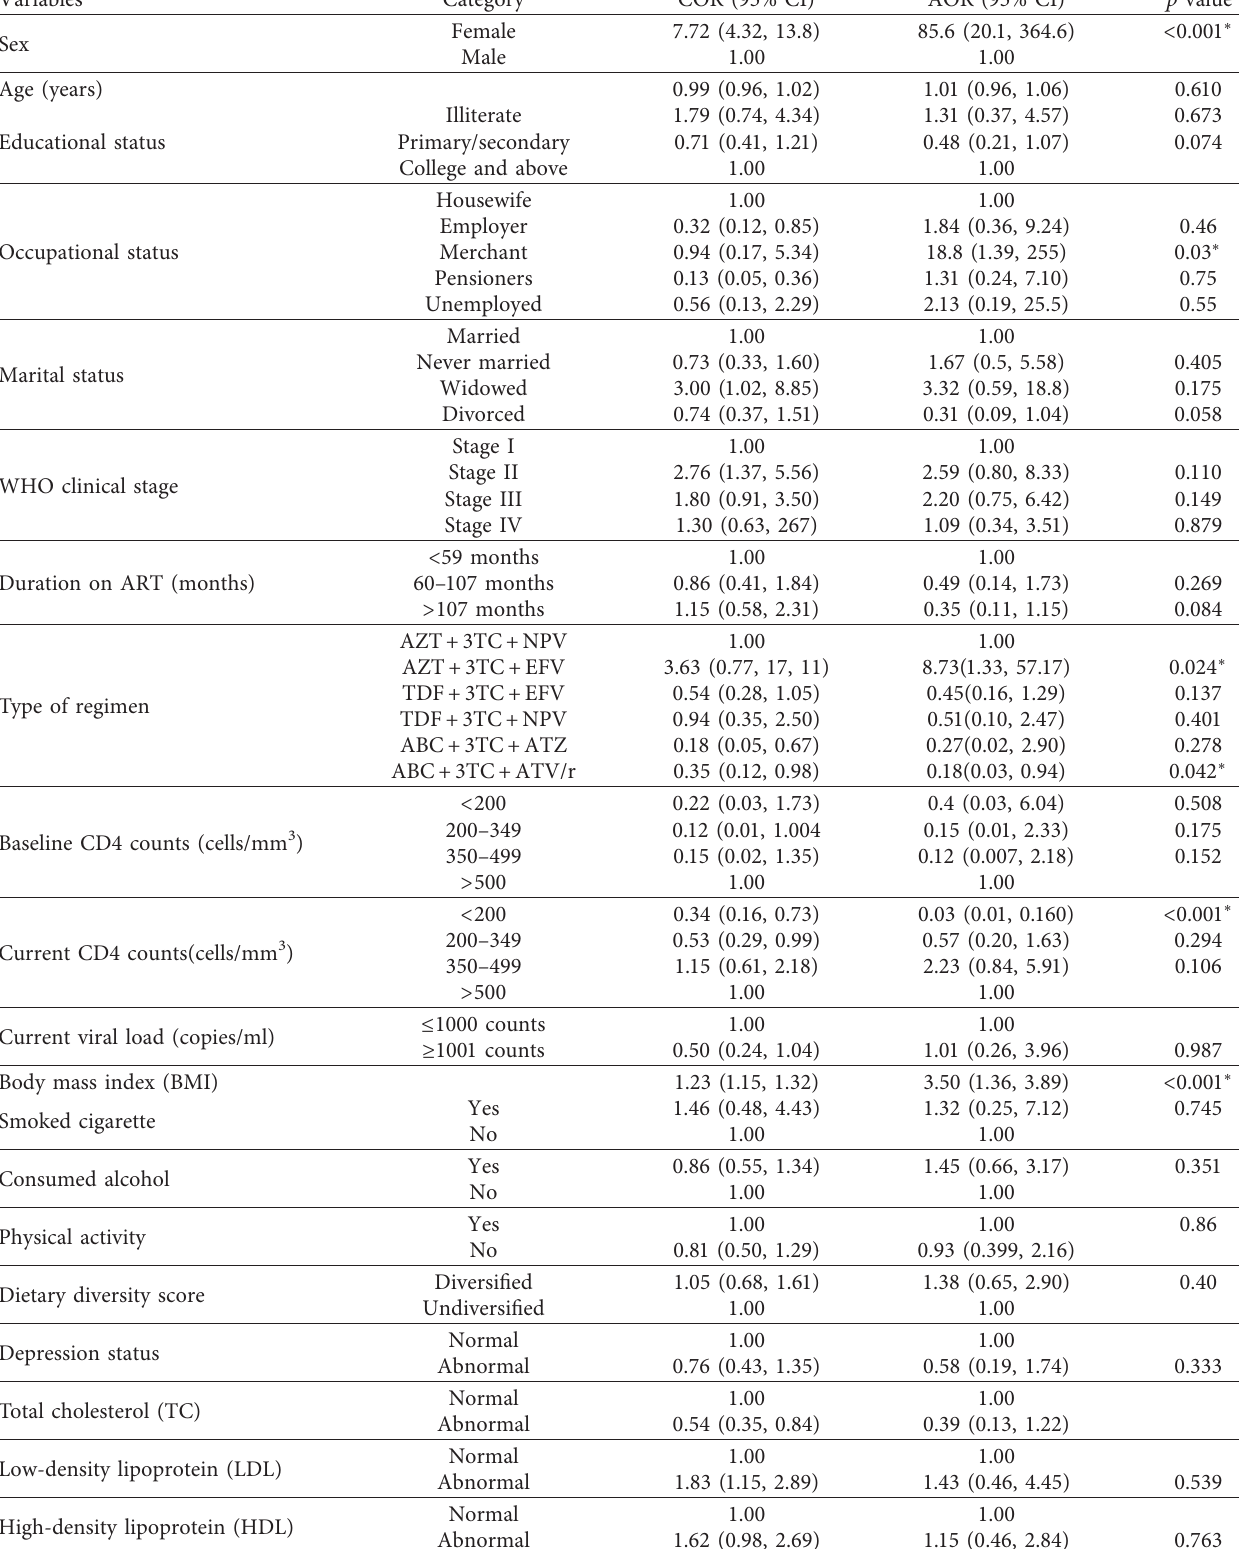
Table 6: Multivariable binary logistic regression analysis to identify factors associated with central obesity among HIV patients who received ART at armed force comprehensive and specialized hospital, Ethiopia, 2018 ( n �